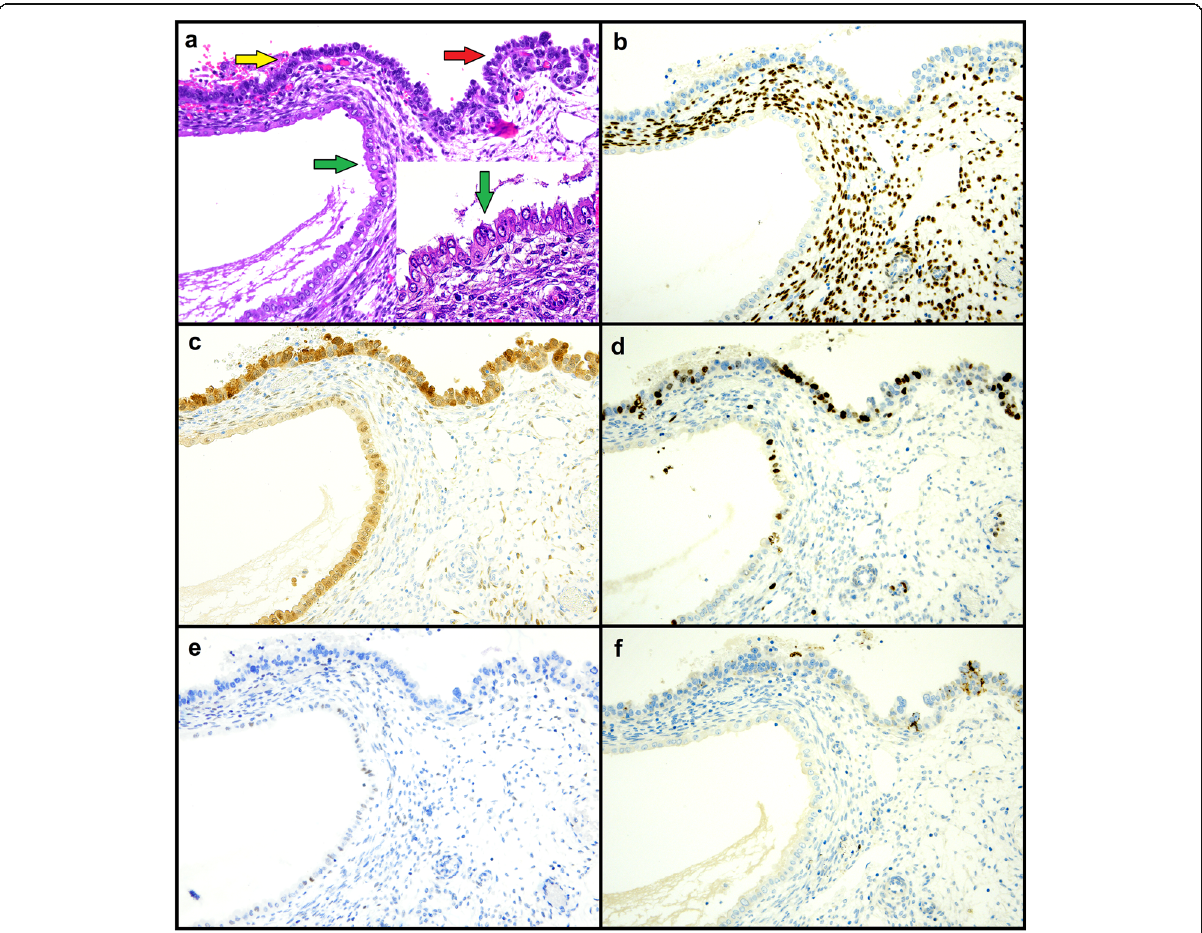
Fig. 2 Case 1. Metaplastic-like putative low-grade precursor (green arrow), putative high-grade precursor (yellow arrow) and CC-EIC (red arrow) (magnification 200X). Hematoxylin-eosin with detail of the putative low-grade lesion ( a ) and immunohistochemistry for estrogen ( b ), p16 ( c ), Ki67 ( d ), p53 ( e ) and Napsin A ( f